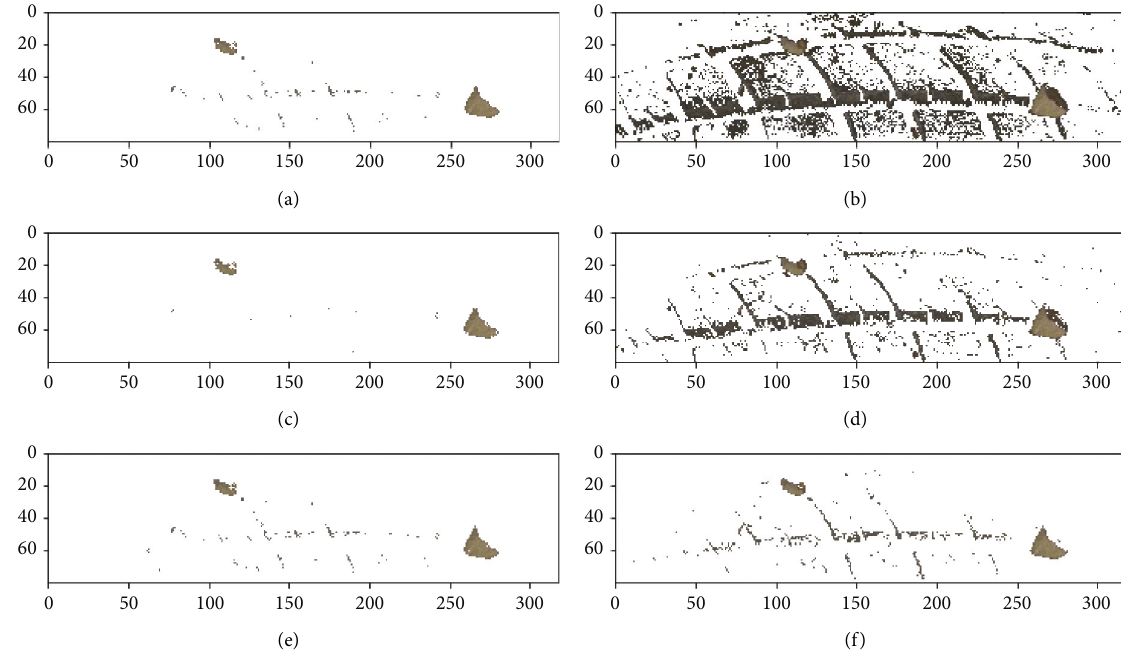
� 7696). (a) Our algorithm with k � 2. (b) k -means with c